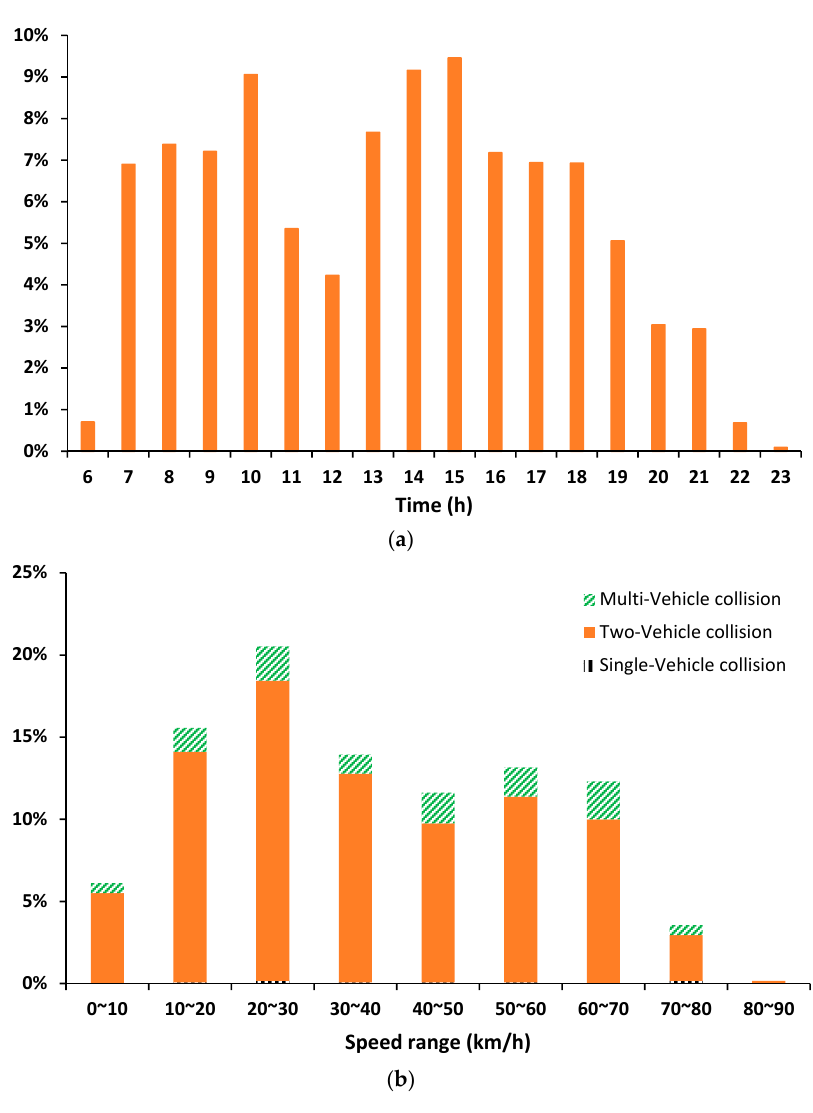
Figure 2. Time and speed distribution of crashes. ( a ) Time distribution of crashes; and ( b ) traffic flow speed distribution before crashes.